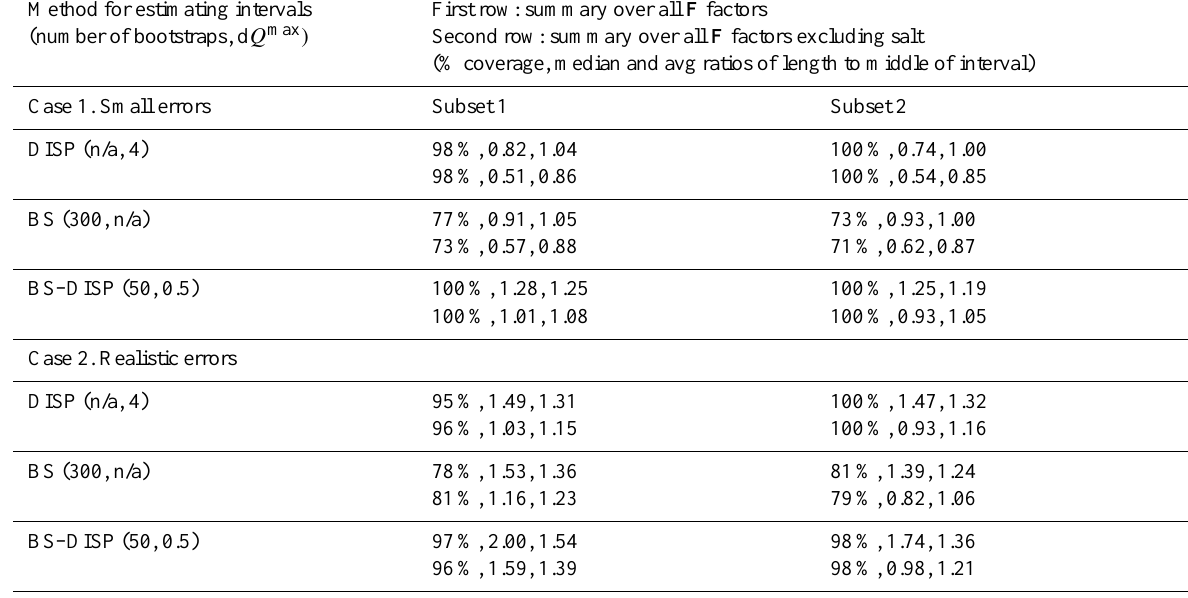
Table 3a. Summaries of F interval estimates for data sets with 50 observations.